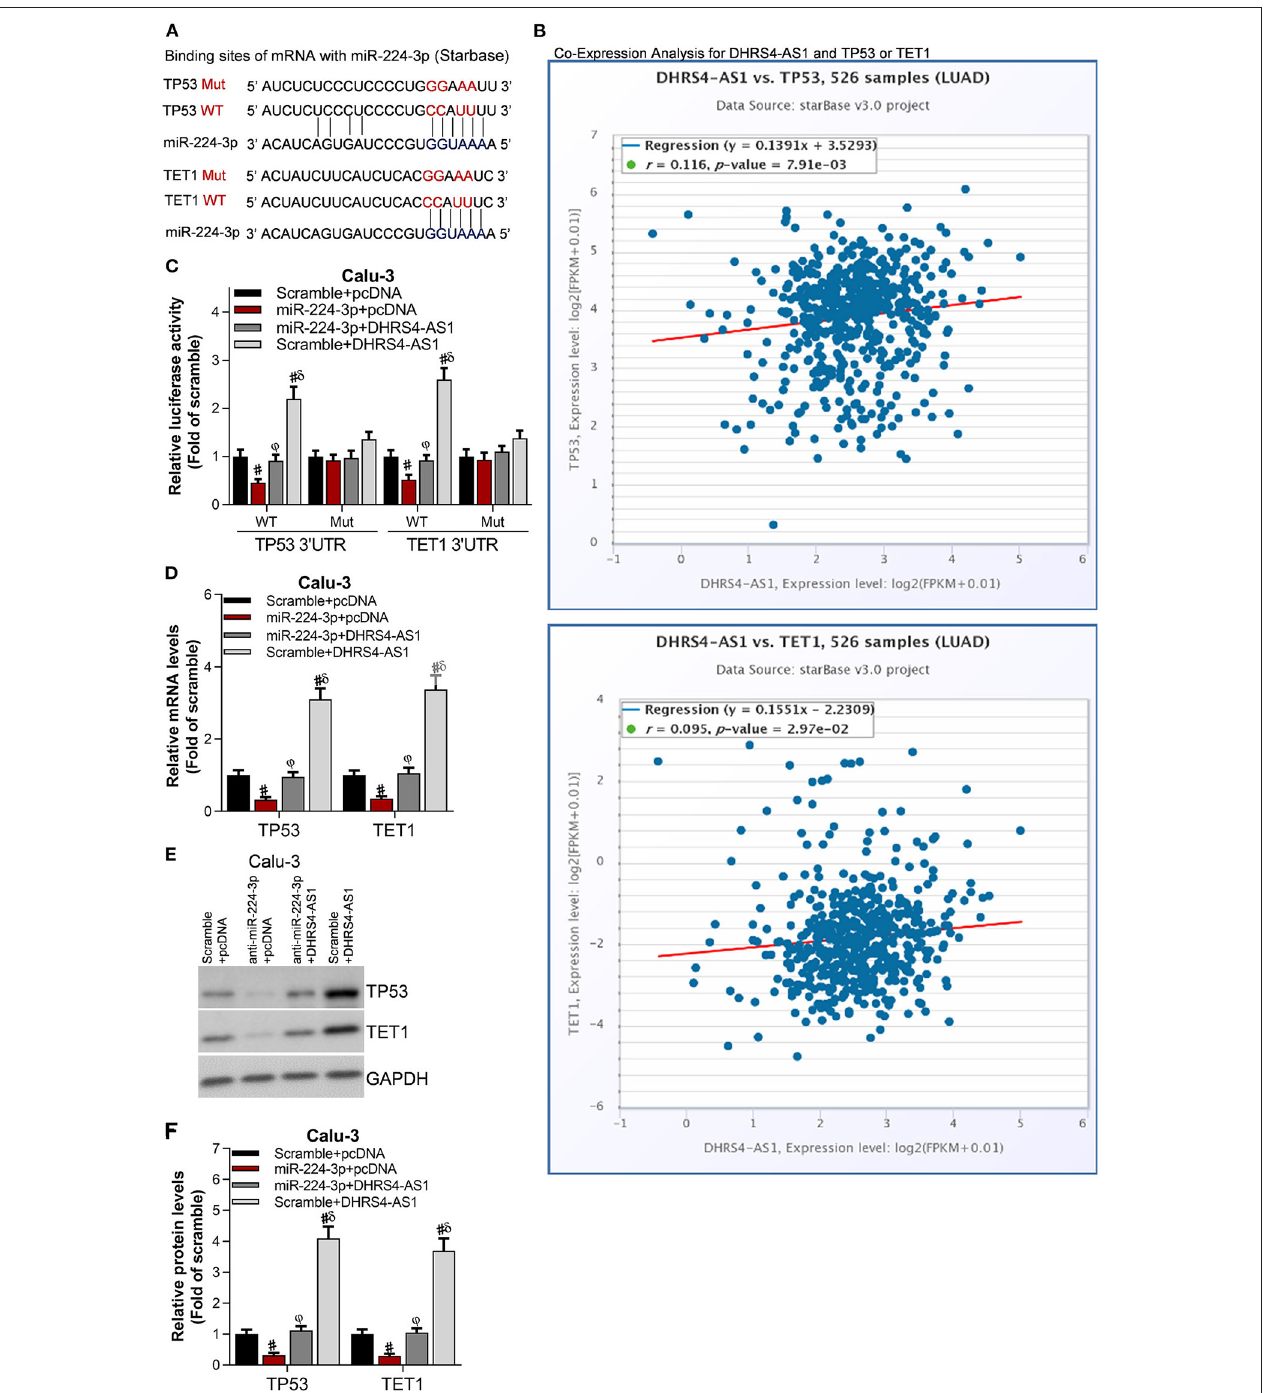
FIGURE 6 | Tumor suppressors, TP53 and TET1 were antagonistically regulated by DHRS4-AS1 and miR-224-3p. (A) Schematic representation of the predicted miR-224-3p binding sites on TP53 and TET1 according to the StarBase prediction. (B) Co-expression analysis of DHRS4-AS1 with TP53 or TET1 according to the StarBase analysis. (C) Luciferase assay of pGLO-TP53-3 ′ -UTR and pGLO-TET1-3 ′ -UTR luciferase activity in transfected Calu-3 cells; # p < 0.01 vs. scramble + pcDNA, ϕ p < 0.01 vs. miR-224-3p + pcDNA, δ p < 0.01 vs. miR-224-3p + DHRS4-AS1. All data was normalized to wild type control group (Scramble + pcDNA) (D) Real-time PCR analysis of TP53 and TET1 expression in transfected Calu-3 cells; # p < 0.01 vs. scramble + pcDNA, ϕ p < 0.01 vs. miR-224-3p + pcDNA, δ p < 0.01 vs. miR-224-3p + DHRS4-AS1. (E,F) Western blot analysis of TP53 and TET1 expression in transfected Calu-3 cells; the optical densities of protein were determined with ImageJ software, # p < 0.01 vs. scramble + pcDNA, ϕ p < 0.01 vs. miR-224-3p + pcDNA, δ p < 0.01 vs. miR-224-3p + DHRS4-AS1. All data are expressed as the mean ± SD from three independent experiments, and each sample was repeated in triplicate.